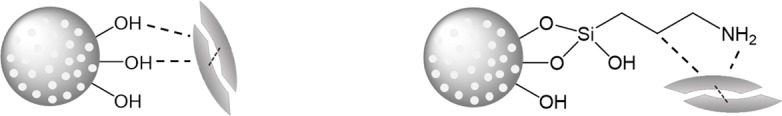
Scheme of the possible interactions between BDNF with (left) unmodified NPSNPs and (right) amino-modified NPSNPs.With unmodified NPSNPs, BDNF can interact via hydrogen bonds and electrostatic interactions, and with amino-modified NPSNPs via hydrogen bonding, electrostatic interactions and via hydrophobic effects. This schematic view does not show the nanoparticles, atoms and the protein with their real sizes.